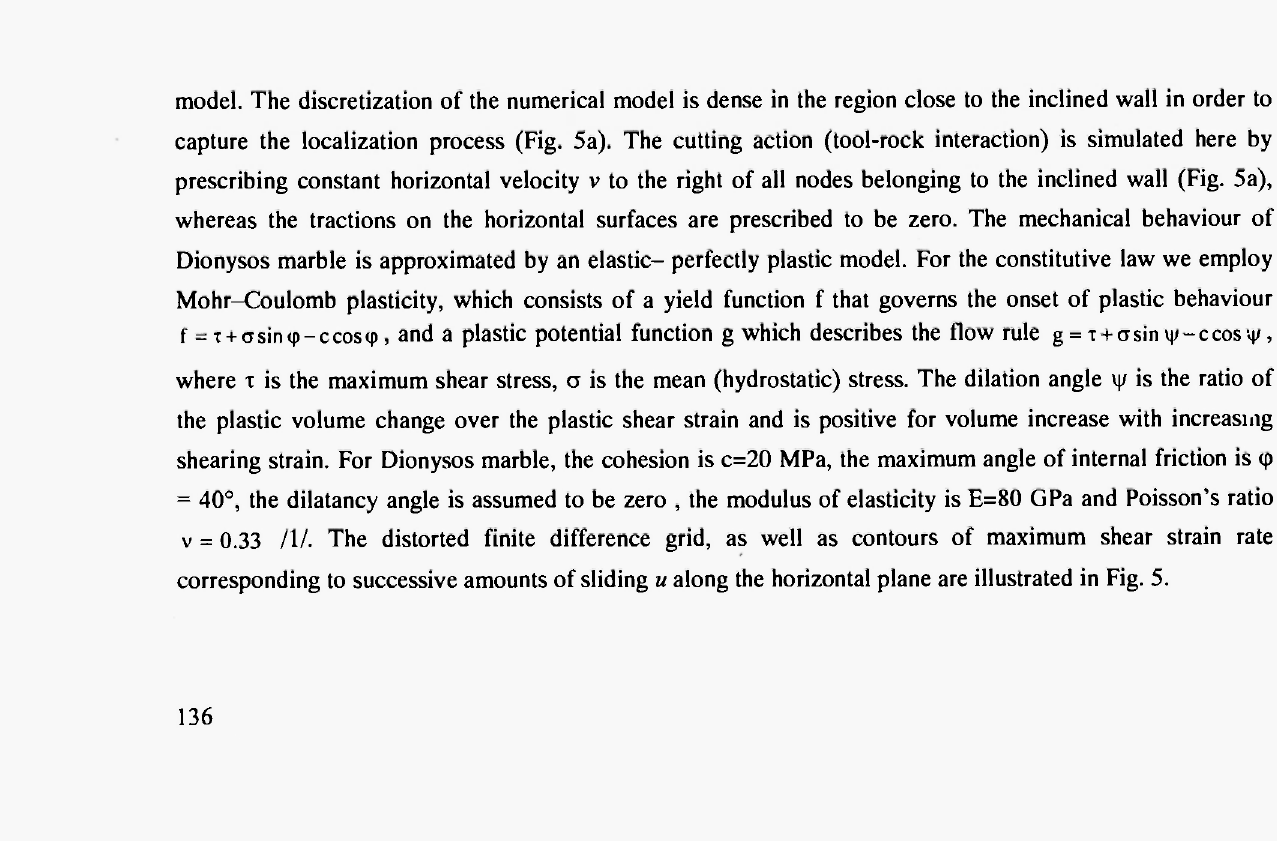
vs. horizontal total reaction force acting on the bit. Fig. 4: Determination of inclination angle of vertical